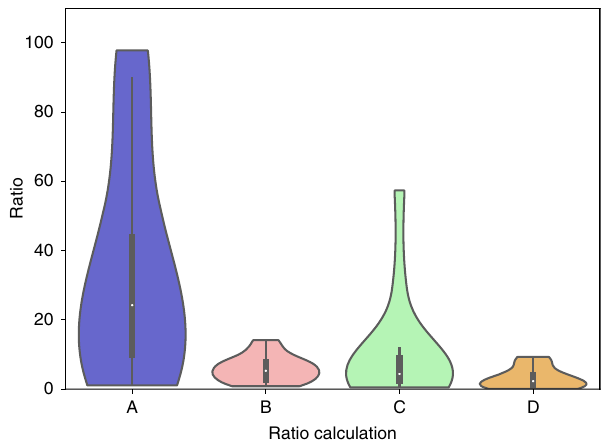
Fig. 3 Violin plot showing the estimated ratio of virus genomic reads to subgenomic reads containing the leader for each of the diagnostic samples included in the study. The ratio is estimated in different ways, including comparing a the total reads for the fi rst 21,500 nucleotides of the virus genome with the total number of subgenomic reads; b the most abundant amplicon in the fi rst 21,500 nt of the virus genome with the most abundant subgenomic RNA amplicon reads; c the most abundant full virus genome amplicon with the most abundant subgenomic RNA amplicon reads; and d the average full virus amplicons reads with the average subgenomic RNA amplicons reads. The median read count ratio is indicated by the white dot, the interquartile range (IQR) by the thick bar, and the furthest values within 1.5*IQR indicated by the thin black line ( n = 14 data points from 12 biological samples from eight individuals run